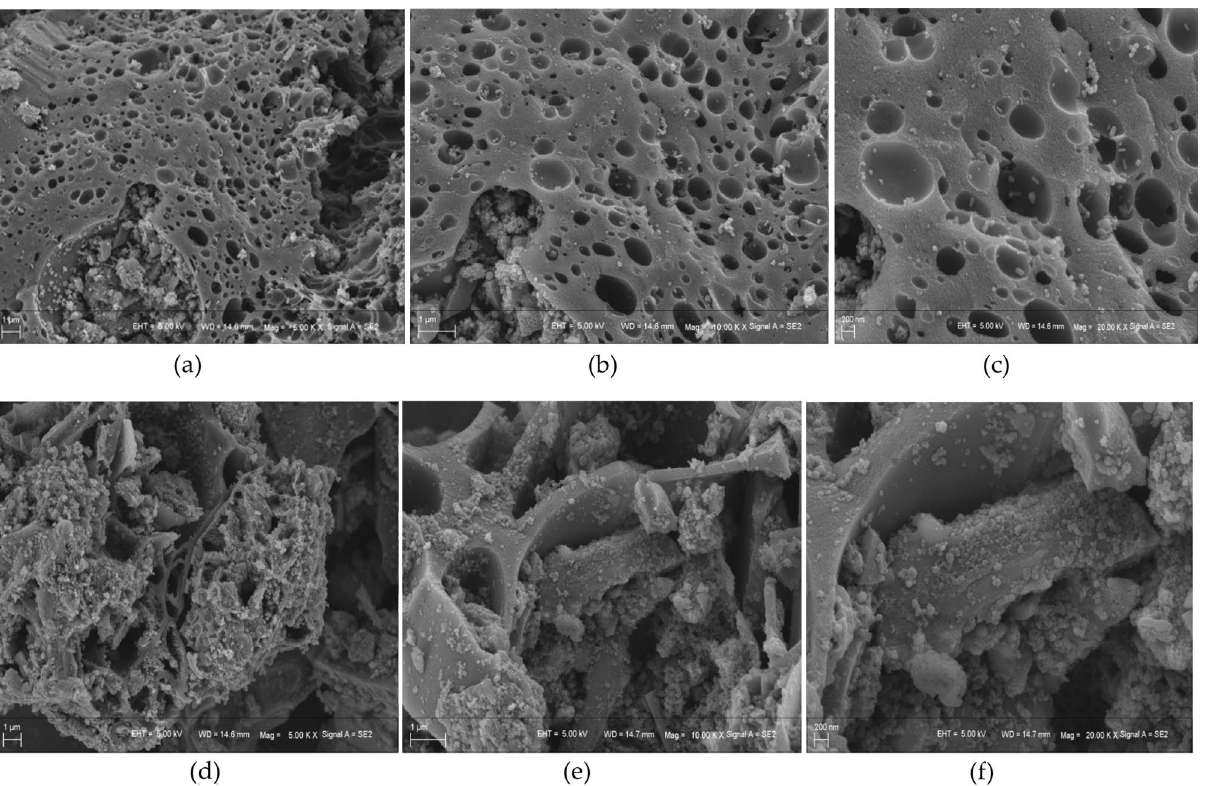
Figure 3. ( a – c ) Images of rice straw biochar magnified by 5,000 times, 10,000 times and 20,000 times under a scanning electron microscope, respectively; ( d – f ) Images of rice straw biochar after anaerobic digestion magnified by 5000 times, 10,000 times and 20,000 times under a scanning electron microscope, respectively.